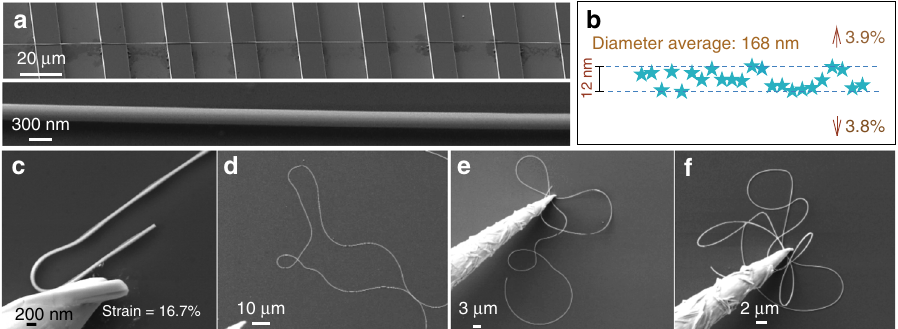
Fig. 2 Diameter uniformity and bendability investigation of Mn 5 Si 3 @SiO 2 nanocables. a A ultra-long nanocable on patterned silicon grooves. b The thickness distribution along longitude direction. c A piece of nanowire bended with 16.7% strain. d – f The fl exibility investigation of a nanocable using a tungsten probe in three-dimensional